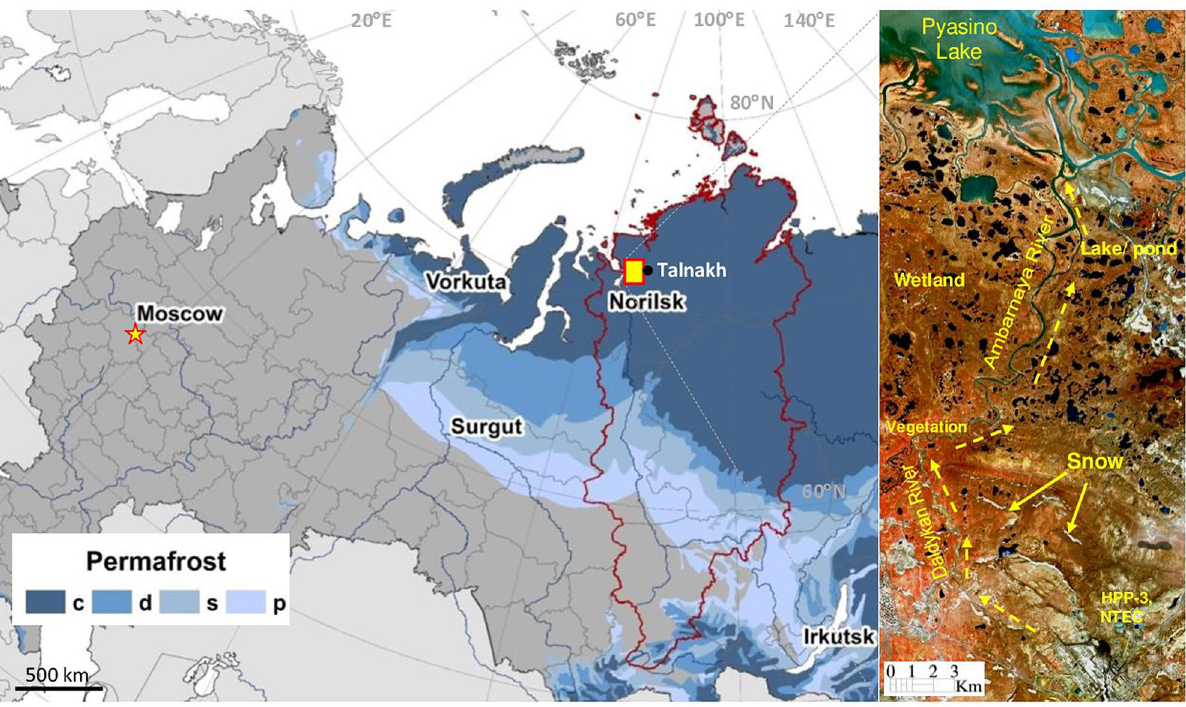
Figure 1. Study area around Norilsk in Krasnoyarskiy Krai, the Federal district of Russia (the border is delineated in red), and distribution of permafrost zones: c—continuous (occupies more than 90% of land), d— discontinuous (50% – 90%), s—sporadic (10% – 50%), p—isolated patches (less than 10%) [Russian Foundation for Basic Research, Project no 18-05-60005]. Insert: Sentinel-2 image [R:6; G;4; B:3, dated May 23, 2020] shows the oil spill direction from the Heat and Power Plant № 3 [HPP-3] of Norilsk-Taimyr Energy Company [NTEC] through the Daldykan River and Ambarnaya River [ENVI 5.5 https ://www.harri sgeos patia l.com; https ://senti